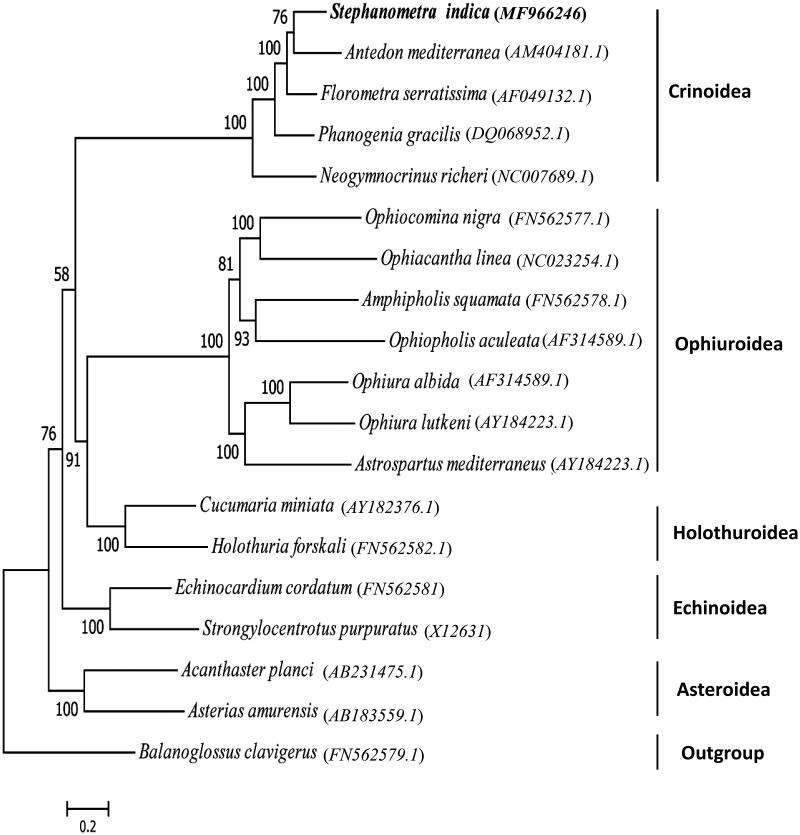
Phylogenetic analyses of S. indica and other echinoderms were conducted based on 13 mitochondrial PCGs using a maximum likelihood (ML) method, Balanoglossus clavigerus (Hemichordata) was used as an outgroup (Perseke et al. 2008).